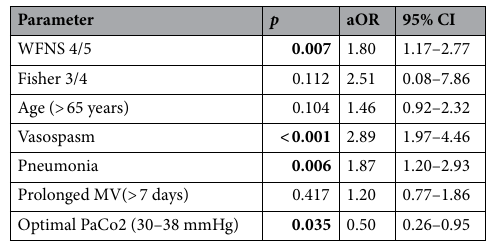
Table 4. Multivariate analysis of factors impacting the occurrence of DCI and poor outcome. Statistically significant p -values are marked bold.